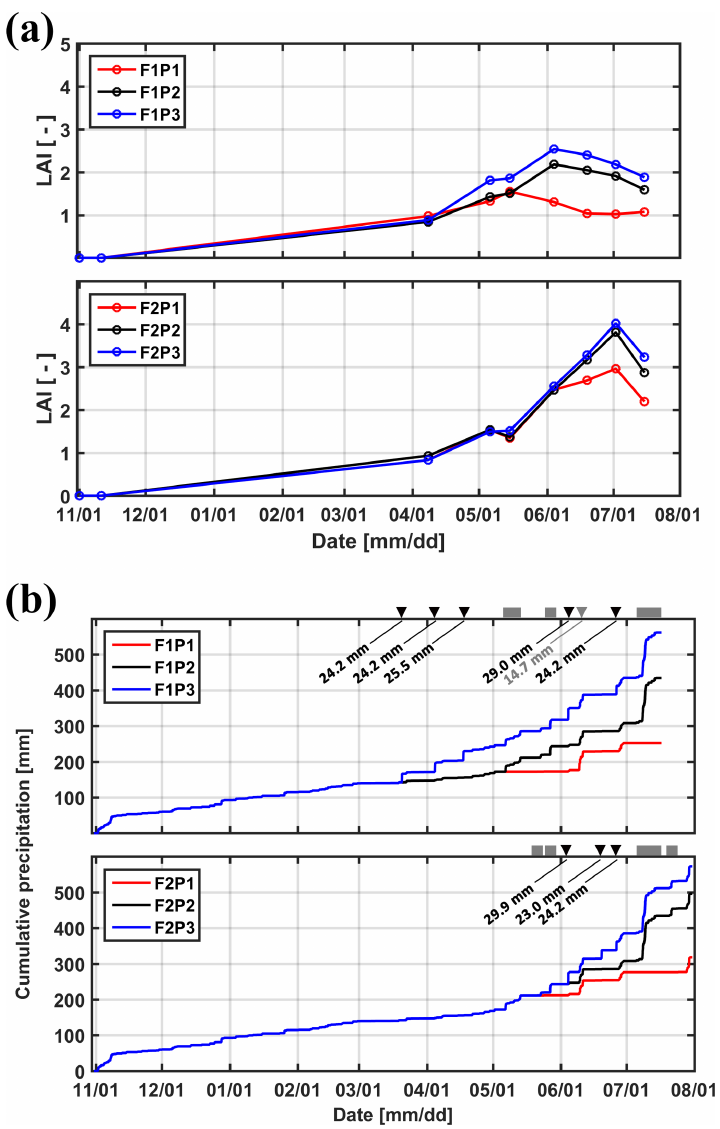
Figure 2. (a) Measured leaf area index (LAI) in the three plots (P1: sheltered; P2: rainfed; P3: irrigated) of the two facilities (F1: stony soil, F2: silty soil). (b) Cumulative precipitation and irrigation applied to the sheltered (P1), rainfed (P2), and irrigated (P3) plots of the stony (F1) and silty (F2) soils. Gray squares: sheltered period; black downward-facing triangle: irrigation in P3; gray downward-facing triangle: irrigation in